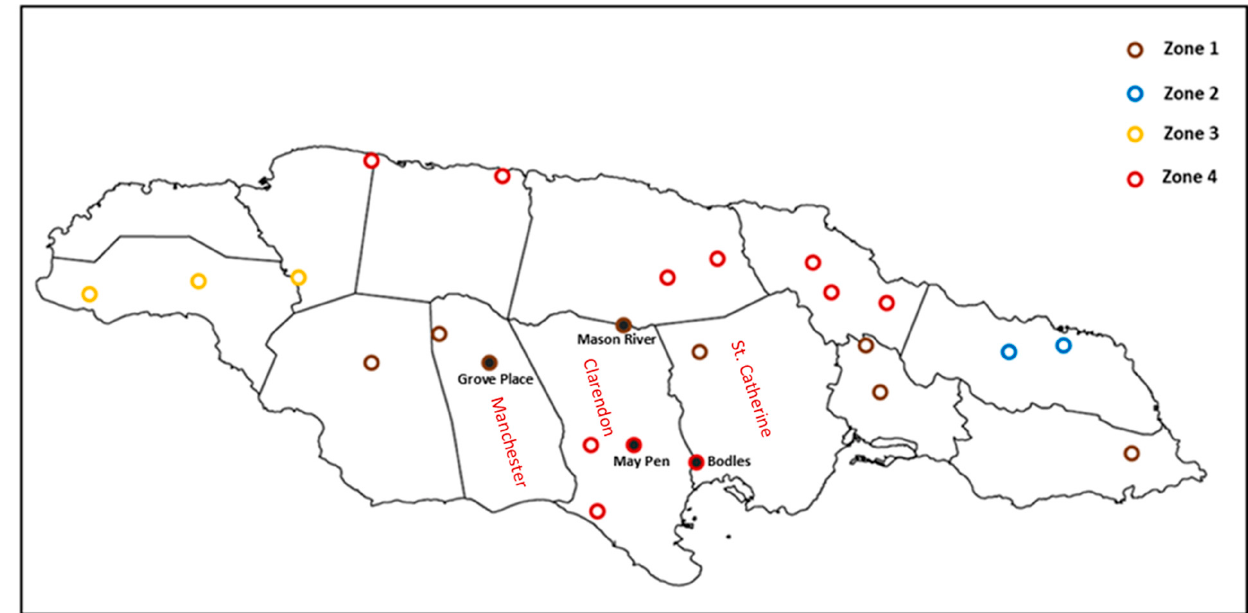
Figure 1. Map of Jamaica differentiating rainfall zones using all-island station locations. The four stations used in the study are highlighted by filling. The three south-central parishes in which they are located are labelled.